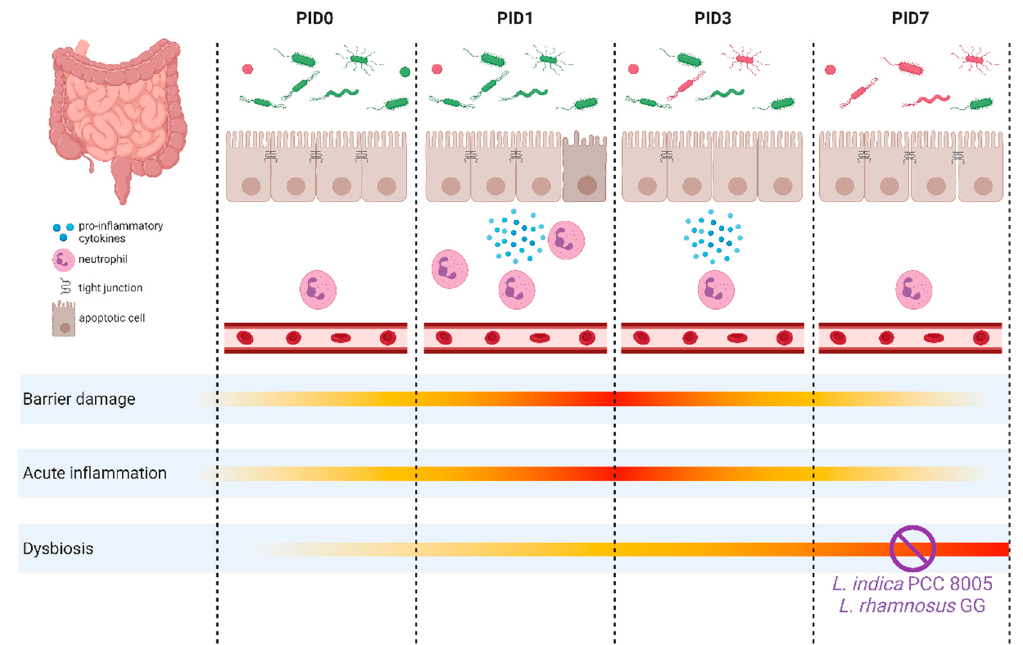
Figure 12. Graphical summary of the main results illustrating the impact of pelvic irradiation on the intestinal ecology based on the different parameters monitored in this study. Pelvic irradiation revealed morphological and inflammatory implications. Concurrent 16S microbial profiling showed a delayed impact of pelvic irradiation on the microbiota composition, which was prevented by both L. indica PCC 8005 and L. rhamnosus GG. This figure was created with BioRender.com and adapted from [3]. PID = post-irradiation day.